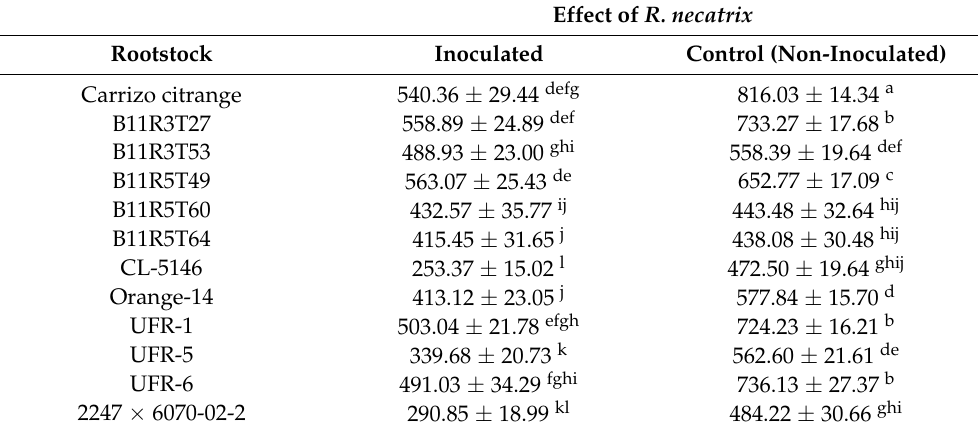
Table 1. Mean standardized area under the chlorophyll progress curve (SAUCPC) ± standard error (SE) due to the effect of R. necatrix (inoculated and non-inoculated) on leaves in 12 citrus rootstocks (Carrizo citrange, B11R3T27, B11R3T53, B11R5T49, B11R5T60, B11R5T64, CL-5146, Orange-14, UFR-1, UFR-5, UFR-6 and 2247 × 6070-02-2).